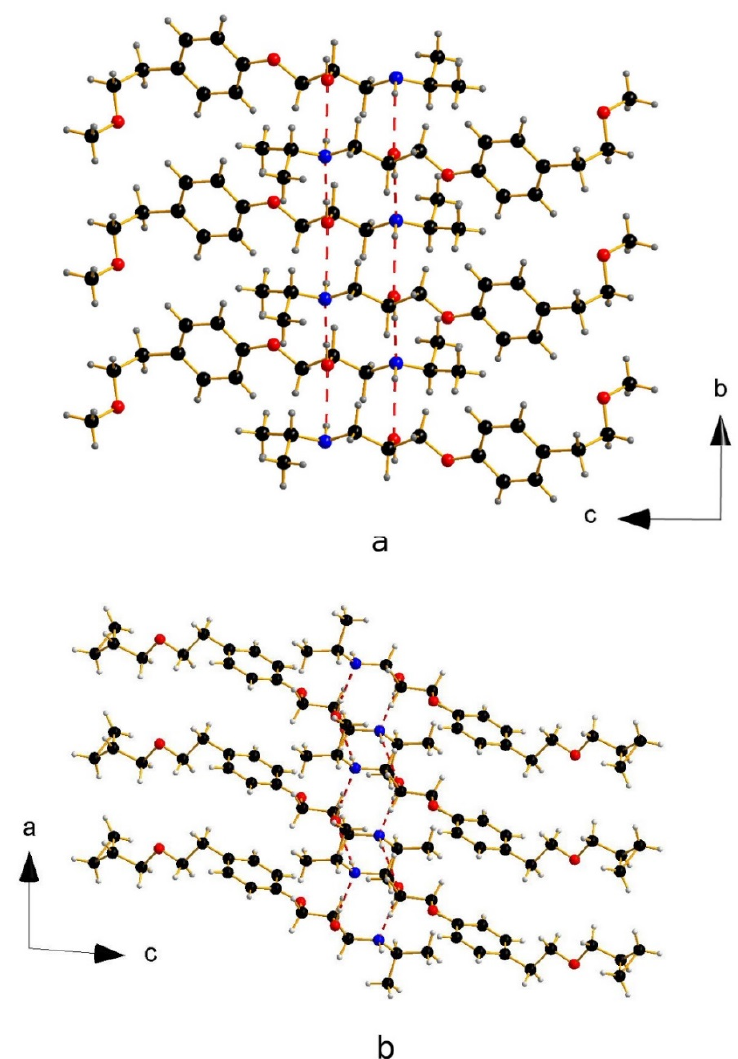
Figure 1. Columns of Active Pharmaceutical Ingredients (API) in metoprolol ( a ) and betaxolol I ( b ).